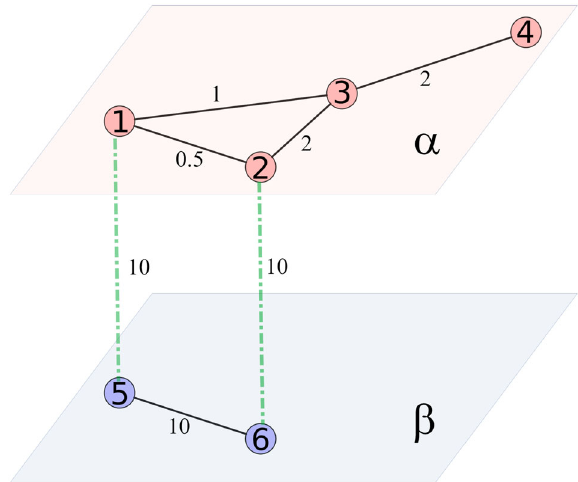
Fig. 8 | Bilayer network composed by layer α possessing 4 nodes and layer β possessing 2 nodes. Layers α and β are interconnected through nodes by a dif- fusion coef fi cient D x